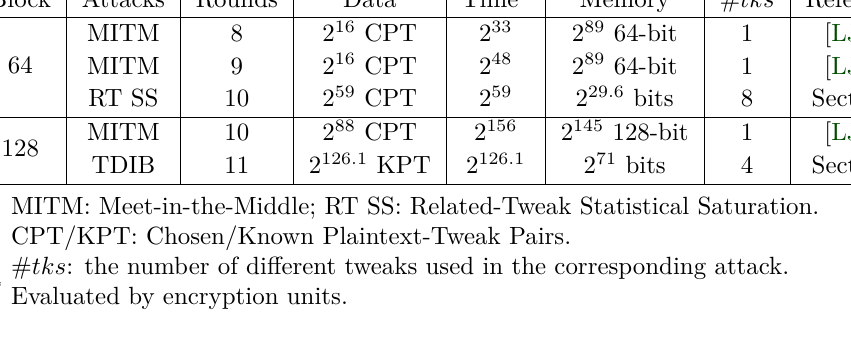
Table 1: Summary of Attacks on Reduced-Round QARMA with Outer Whitening Key